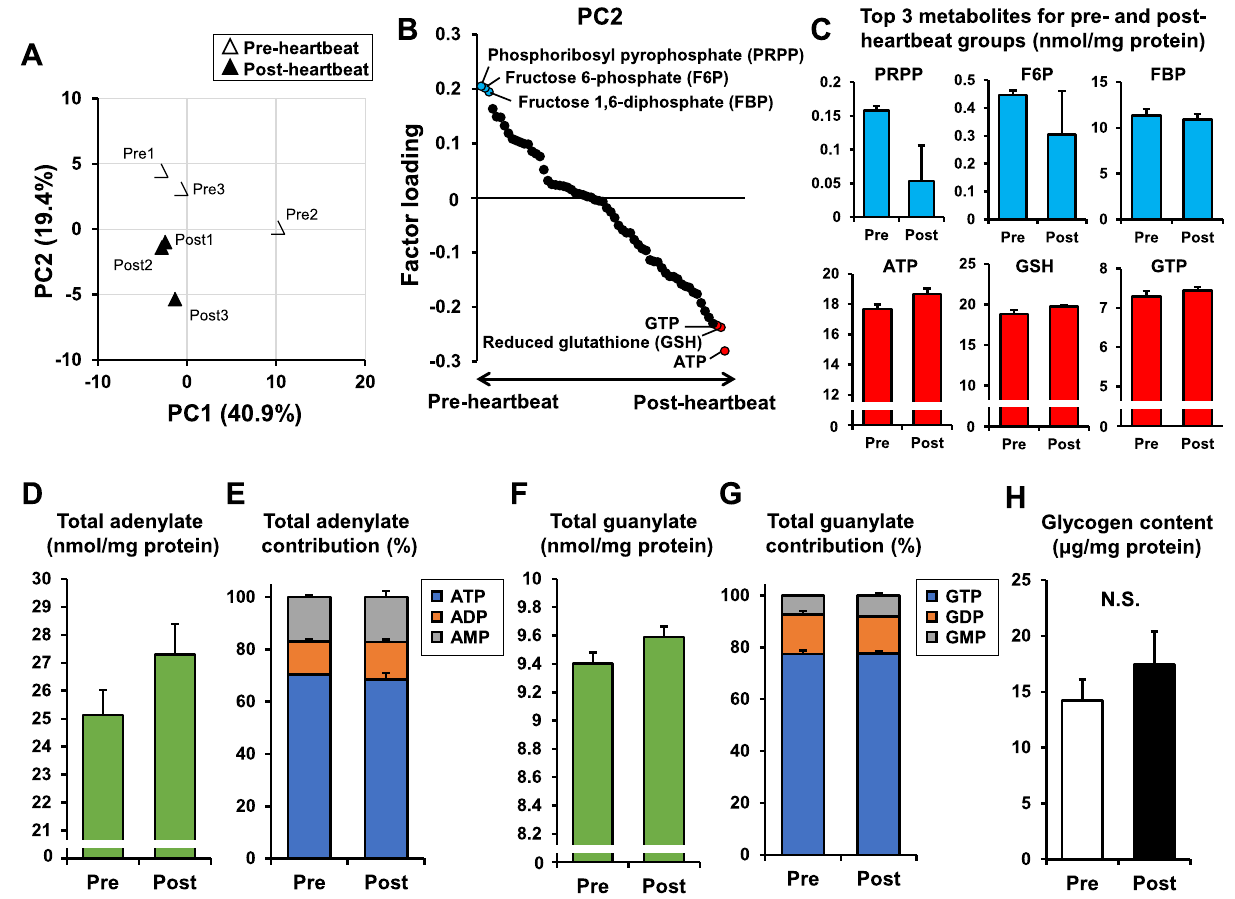
Figure 2. Characteristics of energy metabolites in the heart primordium before and after heartbeat initiation. ( A ) Score plot of principal component analysis in the metabolome analysis. ( B ) Factor loading plot for PC2. Metabolites detected in the metabolome analysis are arranged on the X-axis in the order of factor loading. Blue dots indicate the top three metabolites showing positive factor loading and red dots indicate top three metabolites showing negative factor loading. ( C ) Individual values of the top three metabolites for the pre- heartbeat group (PRPP, F6P, and FBP) and for the post-heartbeat group (ATP, GSH, and GTP). ( D , E ) Total adenylate and its contribution that were obtained by metabolome analysis in the pre- and post-heartbeat groups. ( F , G ) Total guanylate and its contribution that were obtained by metabolome analysis in the pre- and post-heartbeat groups. ( H ) Glycogen contents assessed by a colorimetric glycogen assay in the pre- and post- heartbeat groups (N = 6). *p < 0.05 with Welch’s t-test. N.S.: not